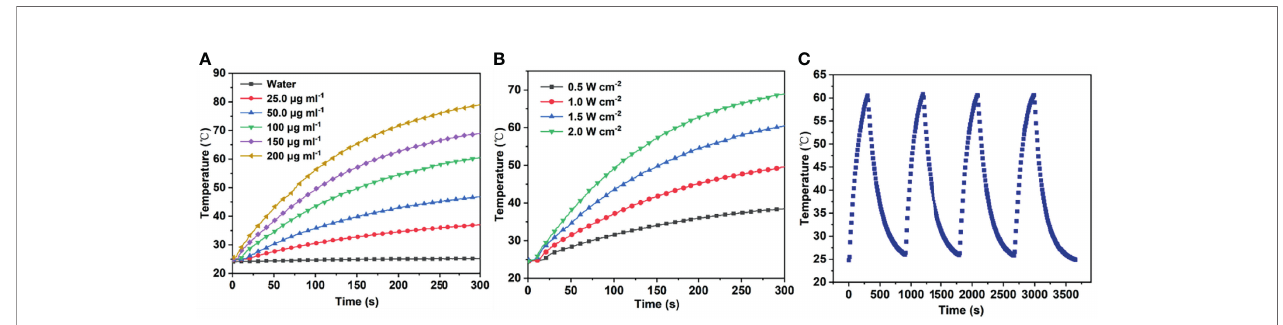
FIGURE 2 | (A) Temperature responses of mPt@PDA-RGD NP solutions with various Pt concentrations under the 808-nm laser. (B) Temperature responses of mPt@PDA-RGD NP solutions (100 m g/ml) under the 808-nm laser with different power densities for 300 s. (C) The heating curve of the mPt@PDA-RGD NP dispersion in deionized water at 4 laser on/off cycles (1.5 W/cm 2 ) under 808-nm laser